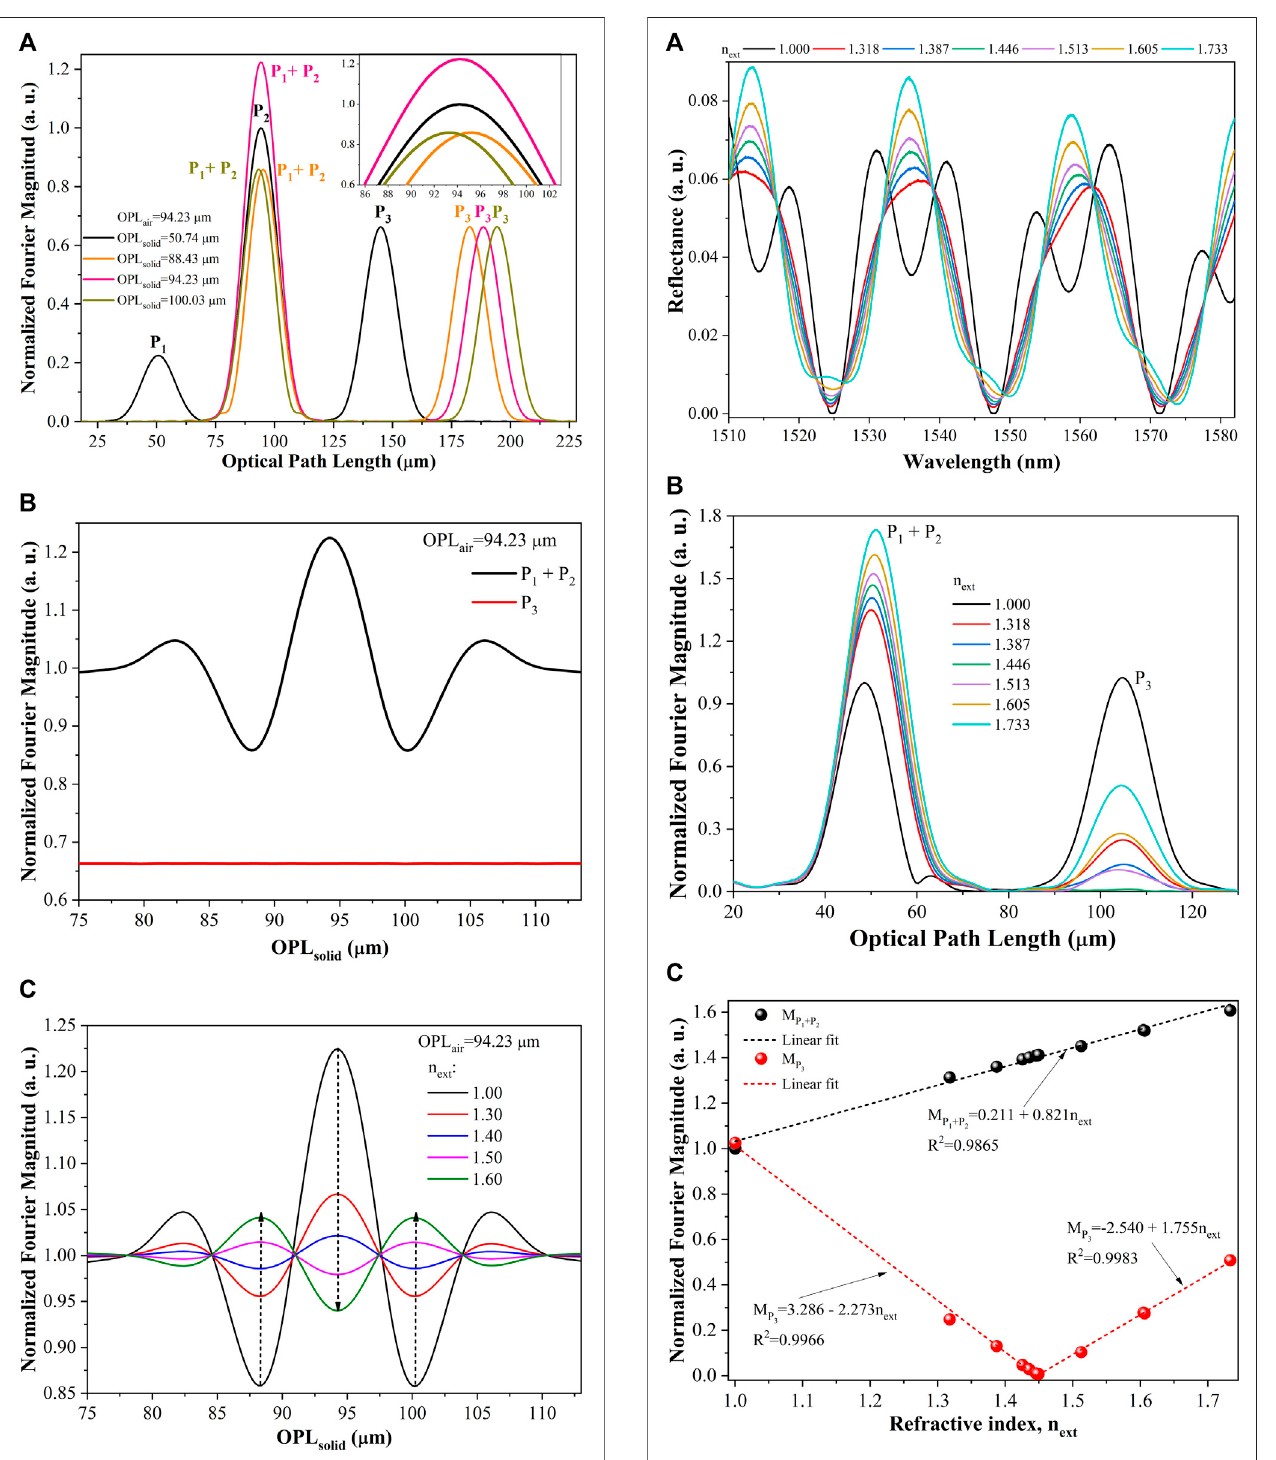
FIGURE 2 | (A) Re fl ectance of the HFFPI in the Fourier domain and (B) maximum amplitude of the overlapped (black line) and P 3 (red line) peaks to different OPL solid while the OPL air was constant. (C) Changes in the maximum amplitude of the overlapped peak for different values of the external refractive index (n ext ). The direction of the arrows indicates a decrement or an augment of the amplitude.